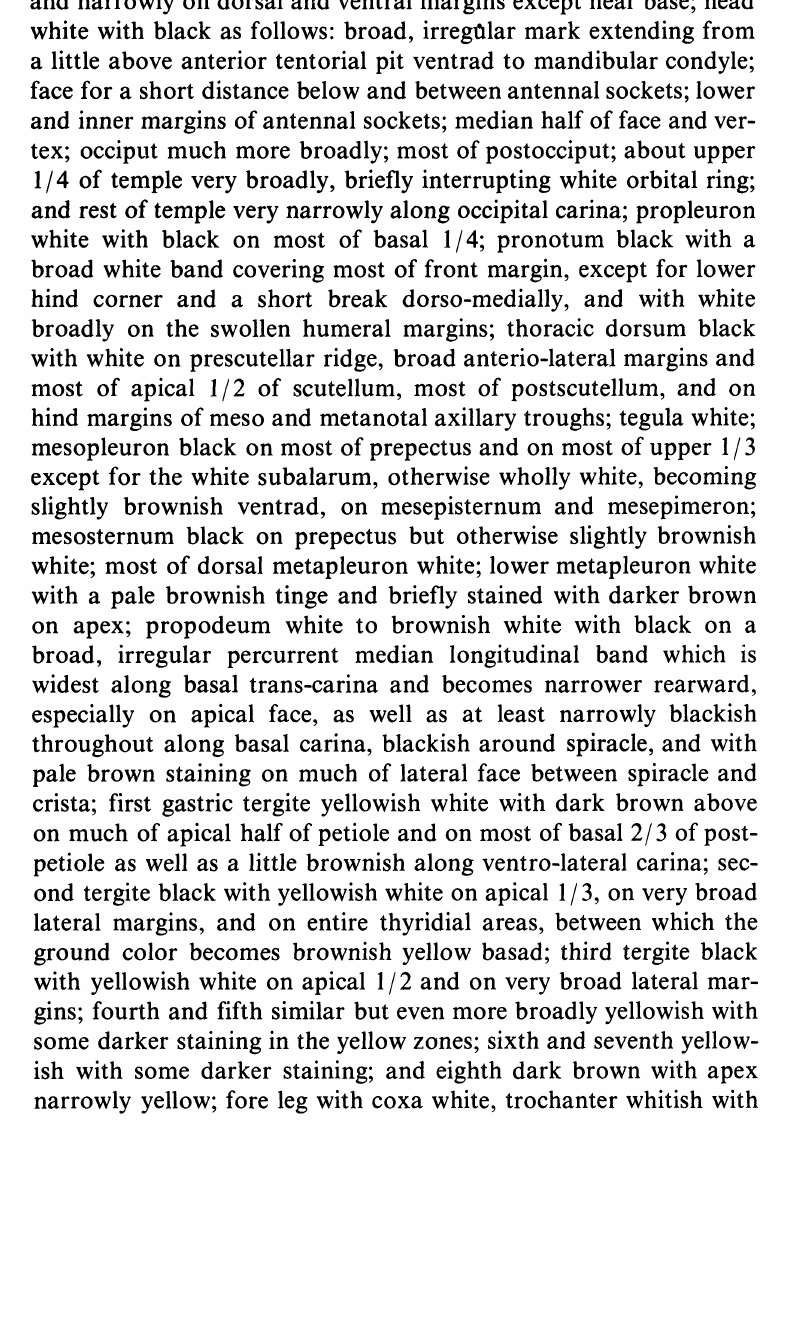
FEMALE: Color: antenna black with white annulus on flagello- meres 5-12; palpi whitish; mandible white with black on apical 1/3 and narrowly on dorsal and ventral margins except near base; head white with black as follows: broad, irregllar mark extending from a little above anterior tentorial pit ventrad to mandibular condyle; face for a short distance below and between antennal sockets;